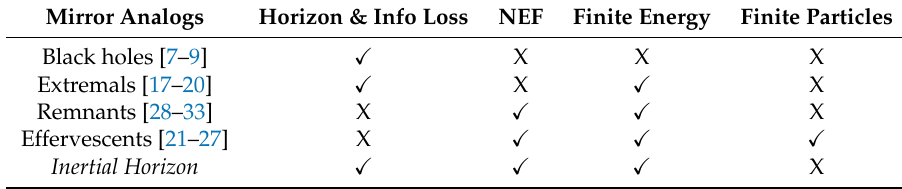
Table 1. The mirror solution in this paper is fairly unique as measured against previously studied trajectories, incorporating NEF and information loss. In this Table, the label ‘Black holes’ refers to Schwarzschild, RN, and Kerr, while the label ‘Extremals’ refer to the extremal RN and extremal Kerr. The label ‘Remnants’ refer to asymptotically non-zero constant velocity trajectories with a residual field mode Doppler shift, and the label ‘Effervescents’ describe complete evaporation trajectories that are asymptotically inertial with zero-velocity and no residual field mode Doppler